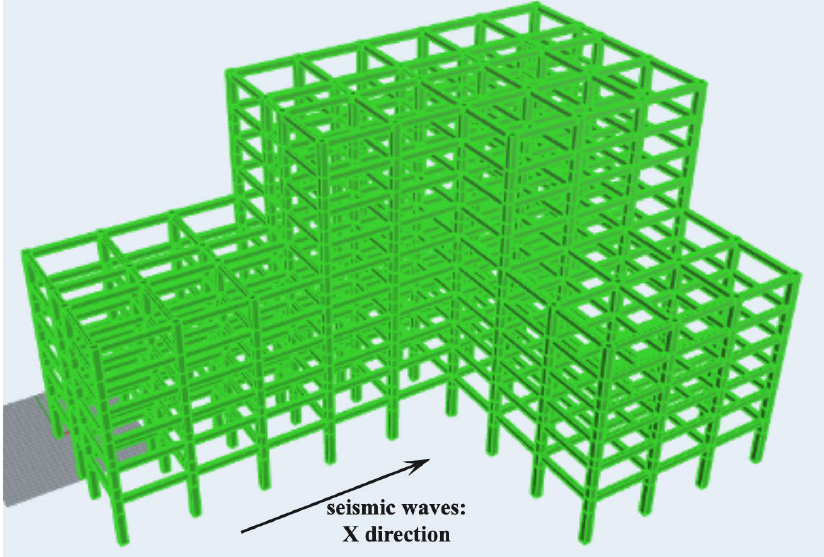
Figure 2. Three-dimensional view of the full-scale spatial eccentric structure model.